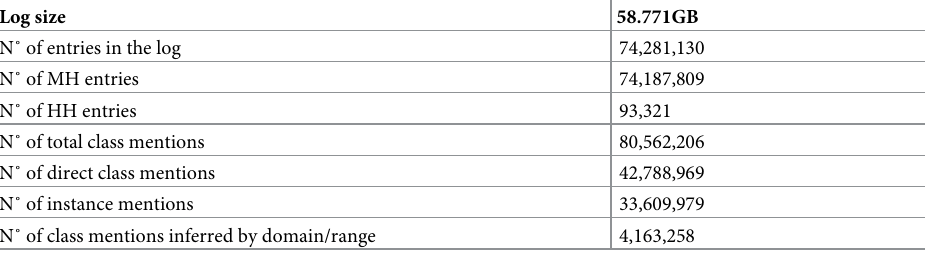
Table 1. Statistics about the DBpedia SPARQL logs